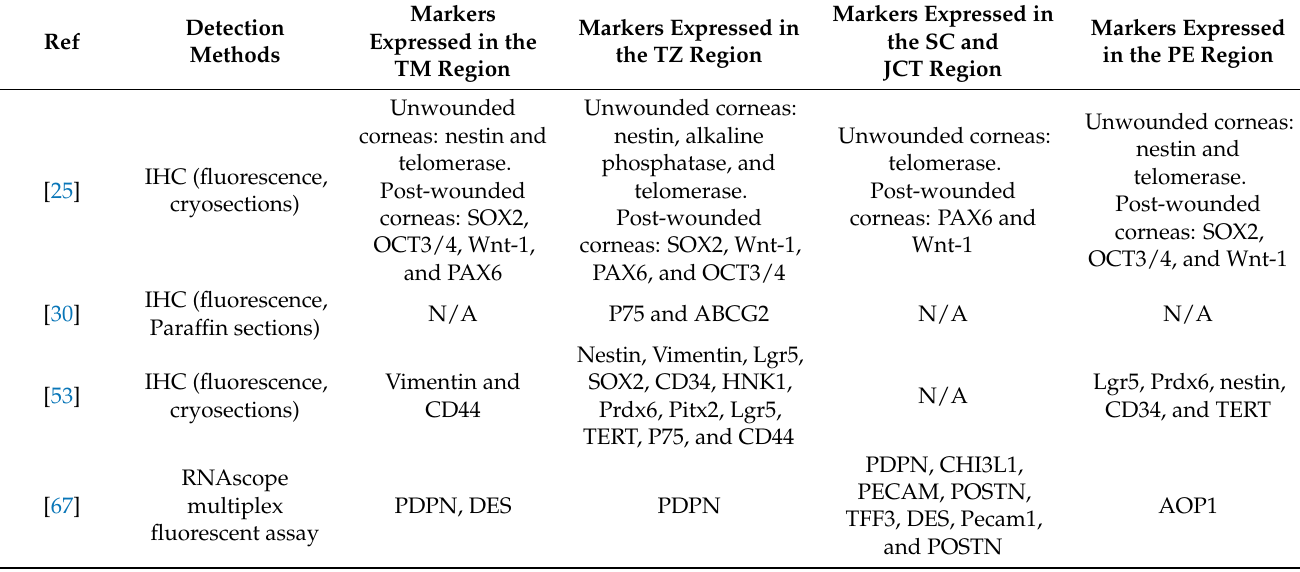
Table 3. Detection of progenitor cell markers in human TM tissue and the method of detection. TZ: transition zone between TM and cornea endothelium; TM: trabecular meshwork; SC: Schlemm’s Canal endothelium; JCT: TM juxtacanalicular region; PE: peripheral endothelium; N/A: not